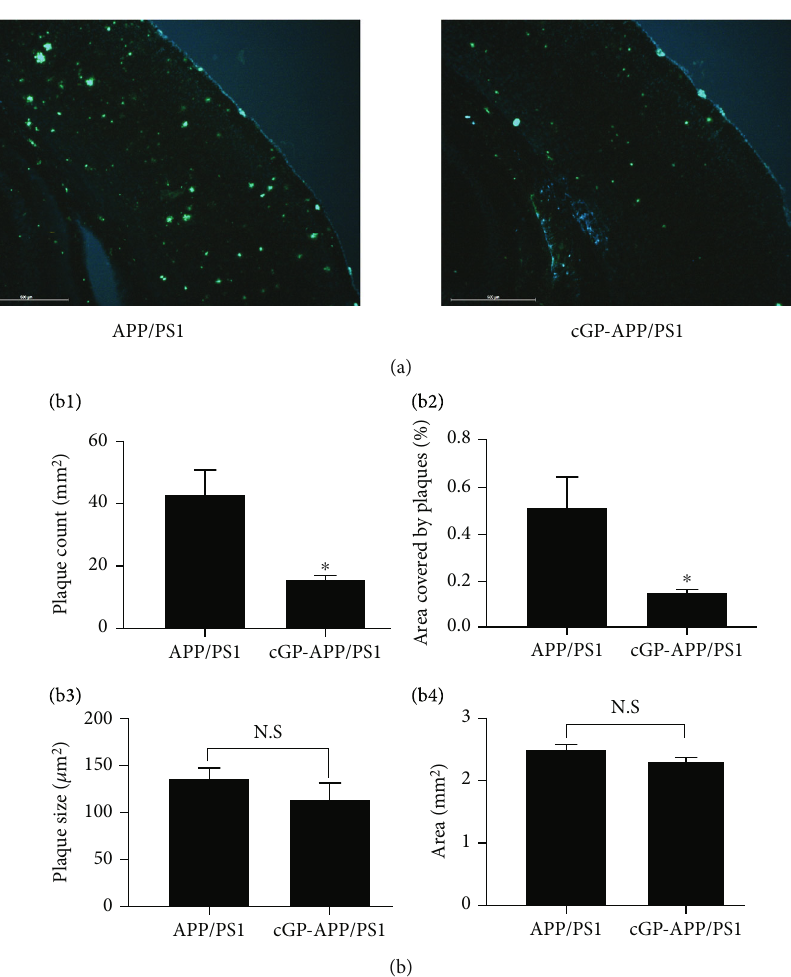
Figure 3: cGP reduces amyloid plaque load in the cortex of APP/PS1 mice. Amyloid plaque load was evaluated in the cortex of APP/PS1 and cGP-treated APP/PS1 (cGP-APP/PS1) mice. Representative thio fl avin-S-stained cortical sections from both groups of mice are shown in (a) (scale bar, 500 μ m). cGP reduced plaque density (b1) and percentage area covered by plaques (b2) in APP/PS1 mice ( n = 4 in both groups). The average size of remaining plaques in cGP-APP/PS1 mice was comparable to plaque size in APP/PS1 mice (b3). The total area used for plaque load analysis (b4) was similar in the two groups of mice. Asterisks denote signi fi cant di ff erence ( p < 0 : 05 ) compared to APP/PS1 group. N.S.: not signi fi